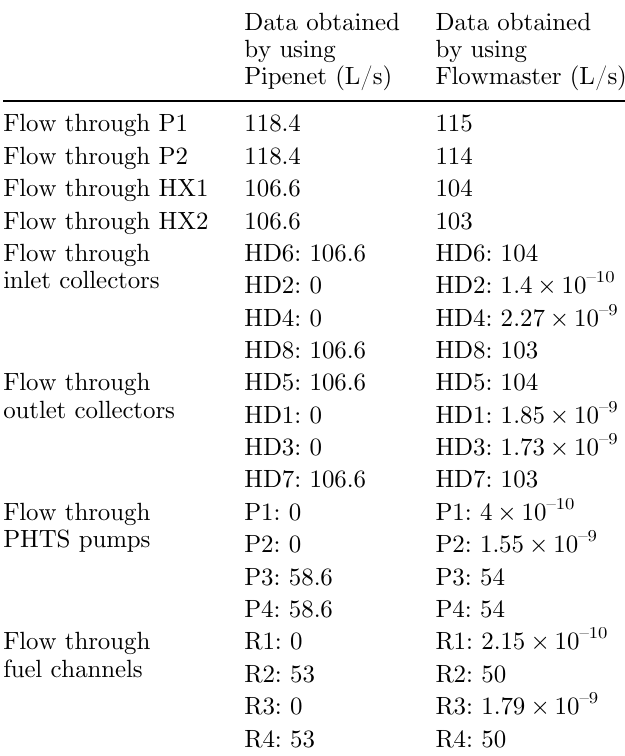
Fig. 4. Examination for 1 HX for cooling agent 30 ° C.